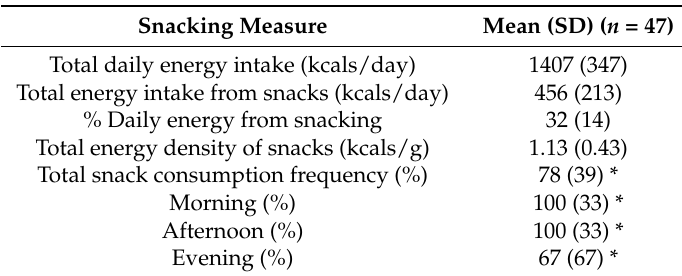
Table 2. Participant Snacking